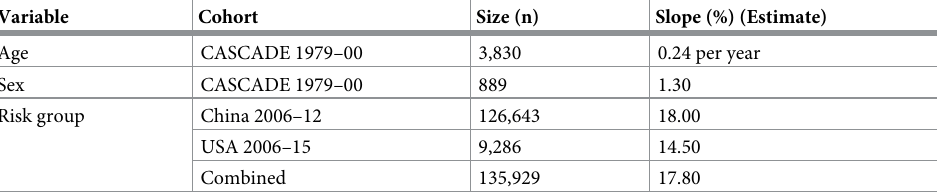
Table 3. Results of regression analysis. The change in R associated slope. Given the dummy coding for sex (0 for female, 1 for male), R T / F is higher in males than females by 1.30 percentage points. Similarly, given the dummy coding for risk group (0 for MSM, 1 for HET), R HET than MSM by * 18 percentage points. (See Methods for details).